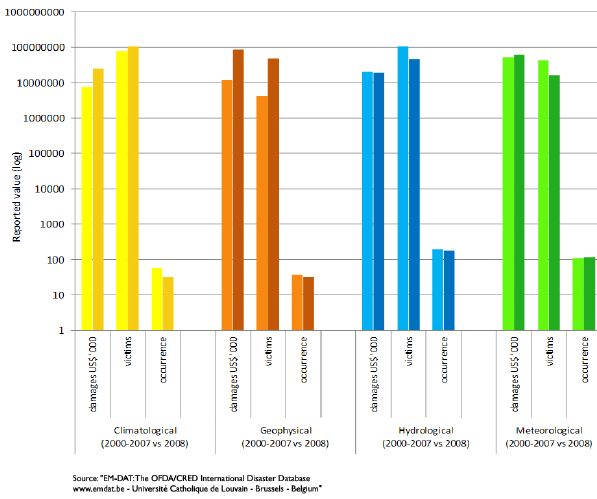
Fig. 1 : The impacts of natural disasters by disaster sub-group (after Rodriguez et al . , 2009): Fig. 1. The impacts of natural disasters by disaster sub-group (after Rodriguez et al., 2009): 2008 (right bars) versus 2000–2007 annual 2008 (right bars) versus 2000-2007 annual average (left bars). average (left